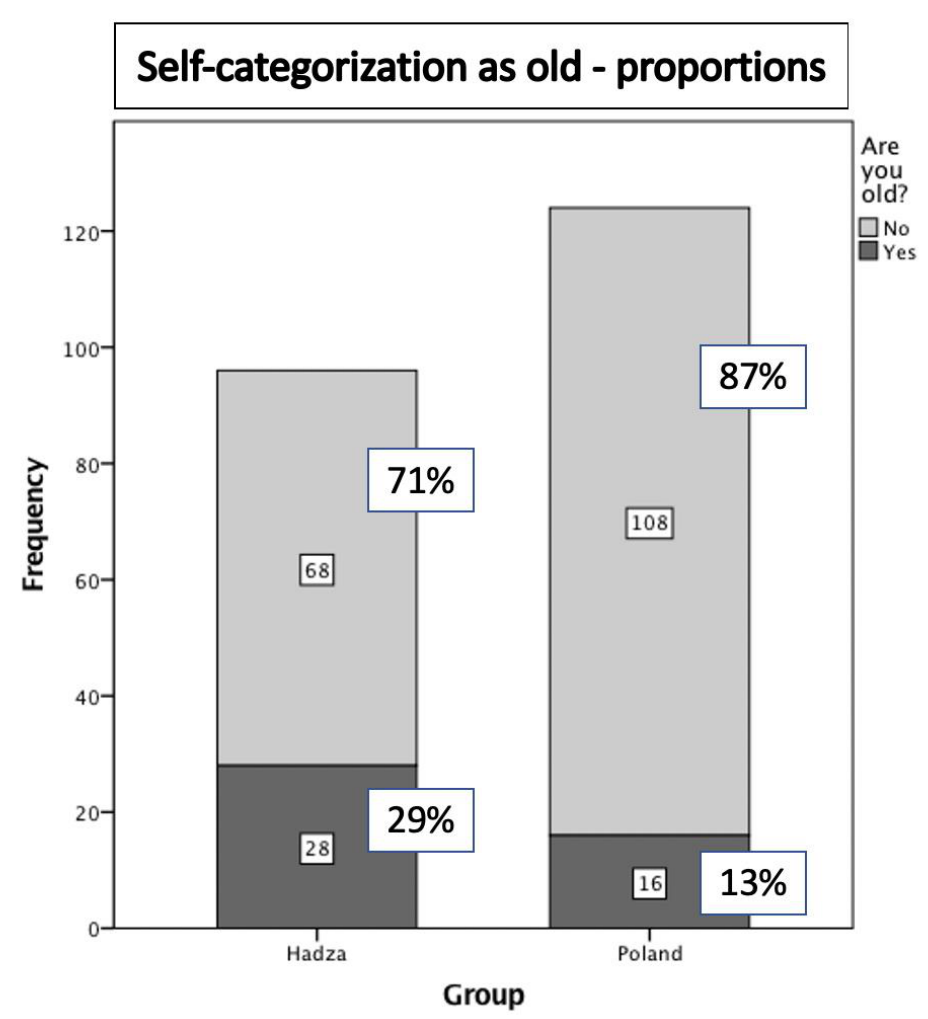
Figure 2. Distribution of self-categorization as old in Polish and Hadza samples .